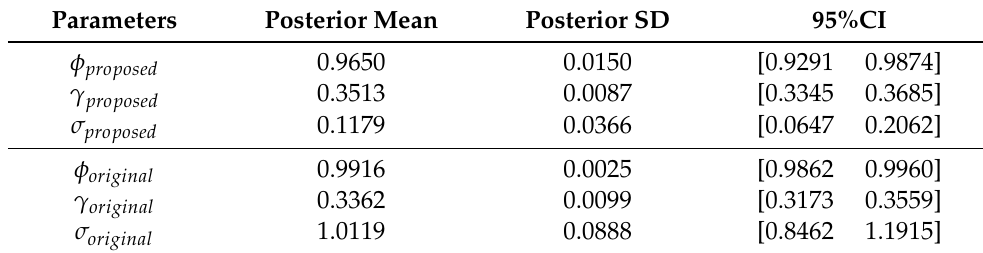
Table 36. Comparison of estimated parameters (23 June 2016, AGH, Tokyo,